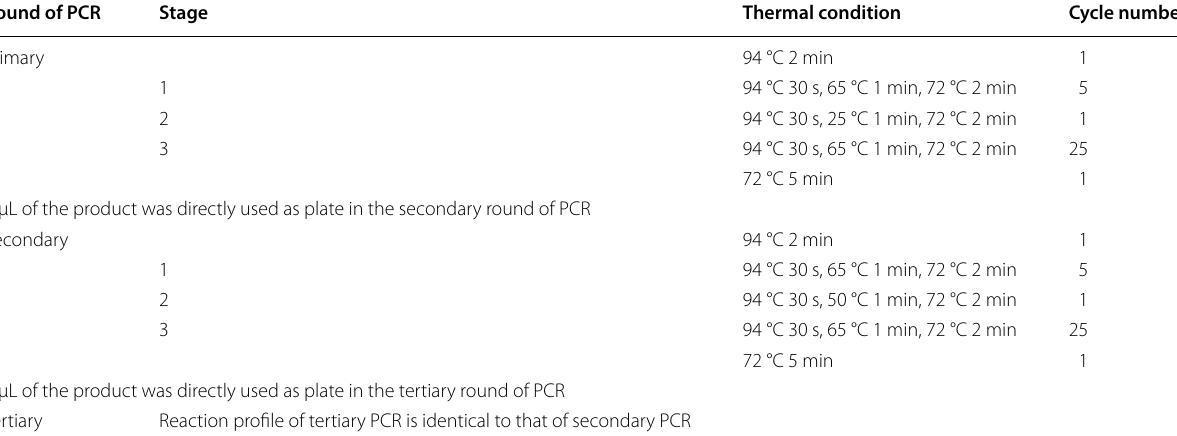
Table 2 Thermal cycling parameters used in SWPOP-PCR method Round of PCR Stage Thermal condition Cycle